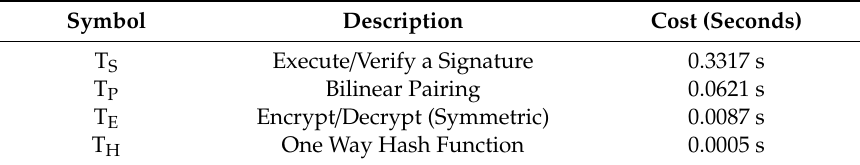
Table 4. Execution time of each operation